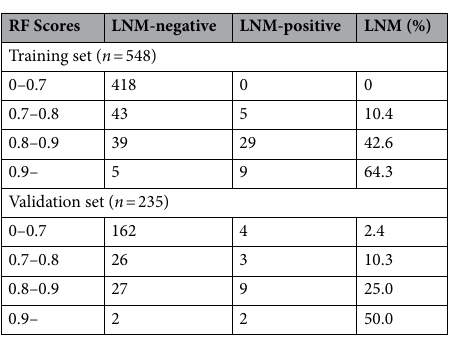
Table 2. Proportion of random forest (RF) scores. LNM, lymph node